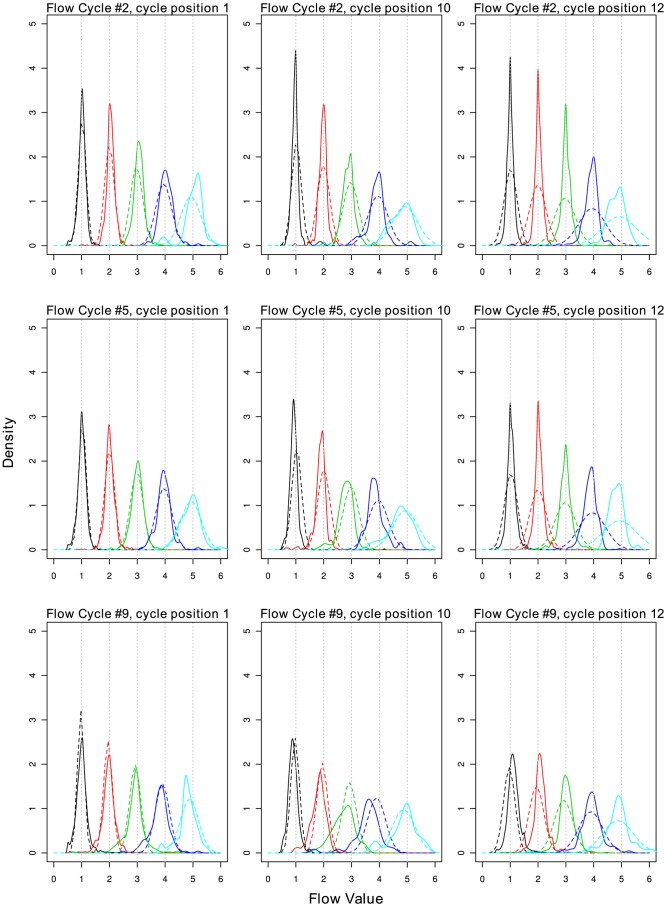
Comparison of predicted versus empirical distributions of flow-values for homopolymers of length 1–5.Predicted (solid line) and empirical distributions (dotted line) of flow-values for homopolymers of length 1–5 (colours - black, red, green, blue and teal), for flow cycles 2,5,9 (rows) and PIC 1,10 and 12 (columns) for species B. amyloliquefaciens. The low number of observations of homopolymers of length 5 is the likely cause for abnormal distributions for this homopolymer length. The ‘shoulders’ observed in the data are often due to unexpectedly high popularity of boundary flow-values (eg. 0.51, 1.49, 1.51…).